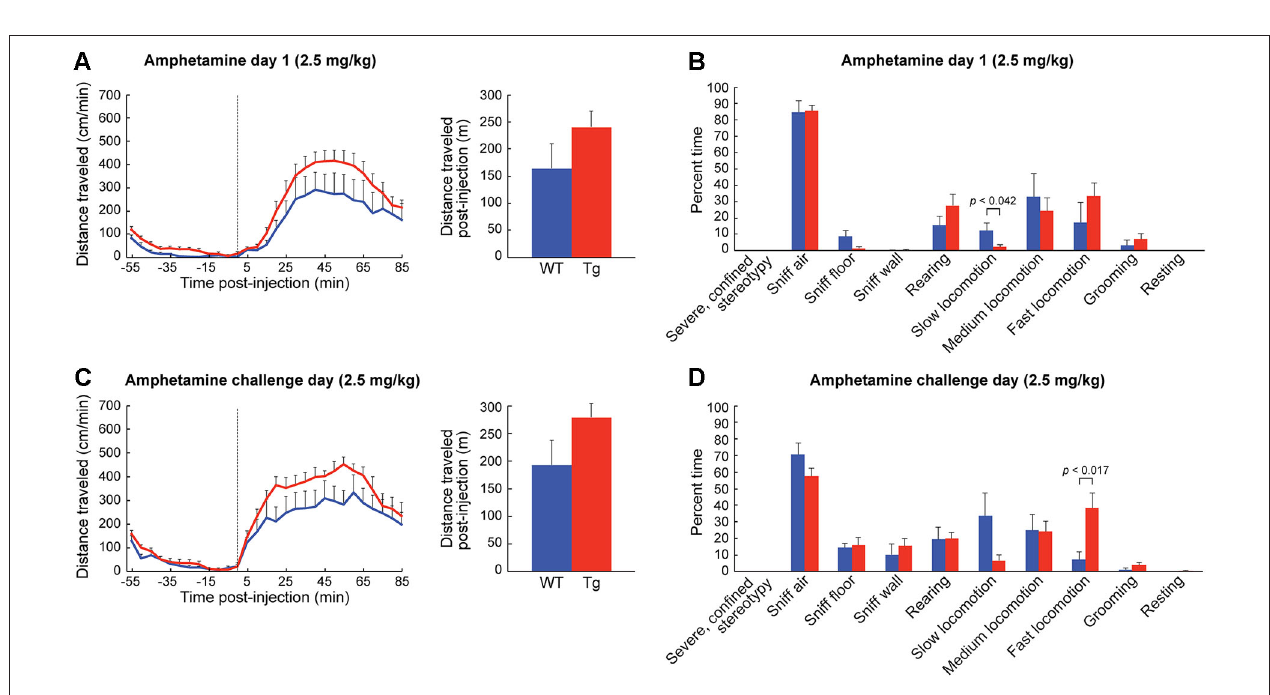
post-injection (85 min) is shown in the bar graph. (B) Observational rating of behaviors, averaged for 50 and 80 min post-injection time-points, on D-amphetamine day 1. (C) Distance traveled measurements and (D) observational ratings on the challenge day of D-amphetamine